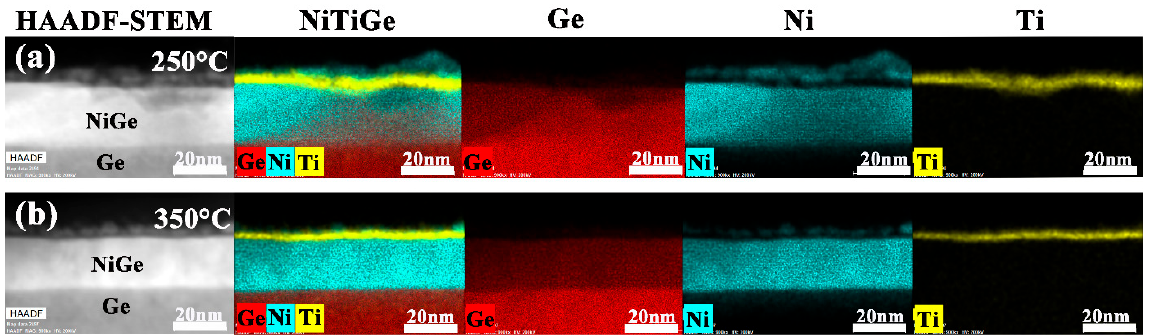
Figure 3. HAADF-STEM and EDS mapping images of the nickel germanide film layer at various temperatures: ( a ) 250 °C, ( b ) 350 °C.